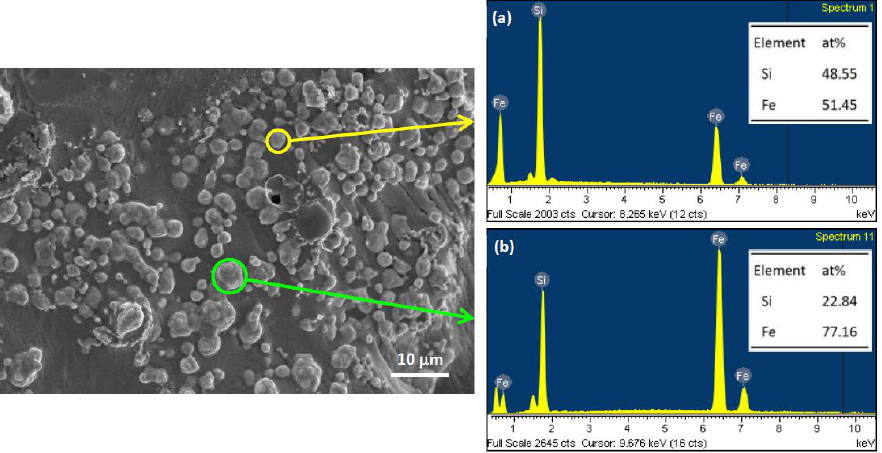
Figure 8. SEM image and EDS spectra associated with ( a ) FeSi and ( b ) Fe 3 Si of SHS-derived product from Reaction (1) with x = 1.5.